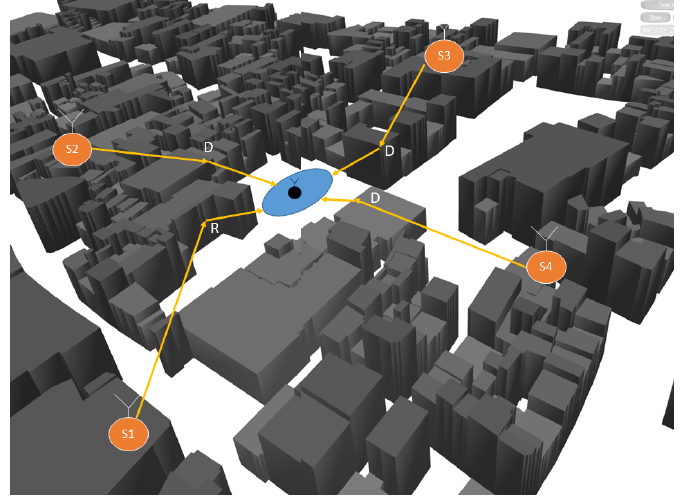
Figure 4. Error caused by NLOS situation in TDOA